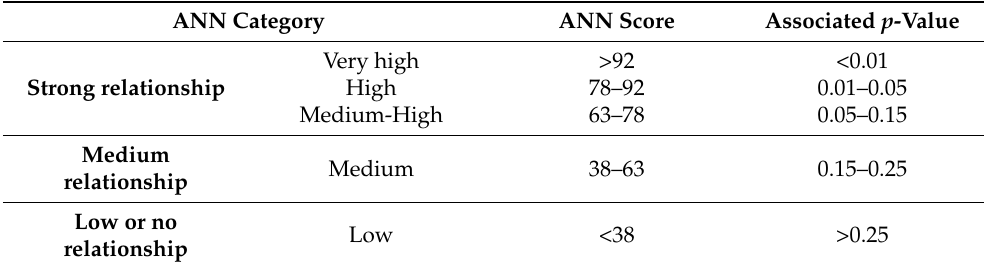
Table 2. Category division of ANN score, in decreasing order, according to probability of being a true positive result. ANN Category ANN Score Associated p -Value Very high >92 <0.01 Strong relationship High 78–92 0.01–0.05 Medium-High 63–78 0.05–0.15 Medium Medium relationship